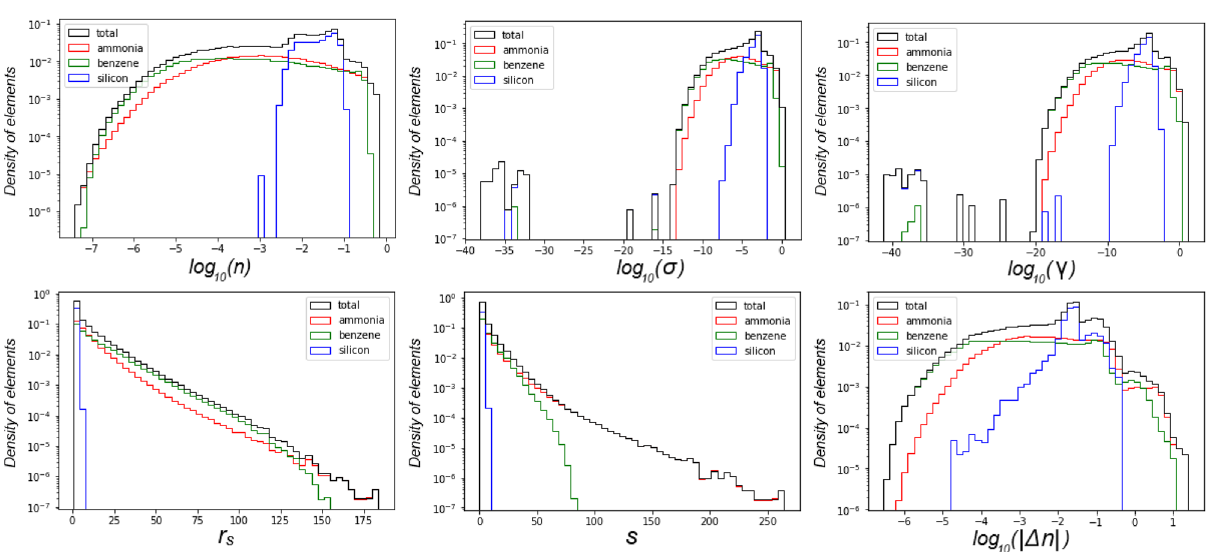
Figure 3. Distributions of input features. Each curve is normalized to to the total number of elements in the corresponding dataset.The distributions localized around the values that are typical for the systems